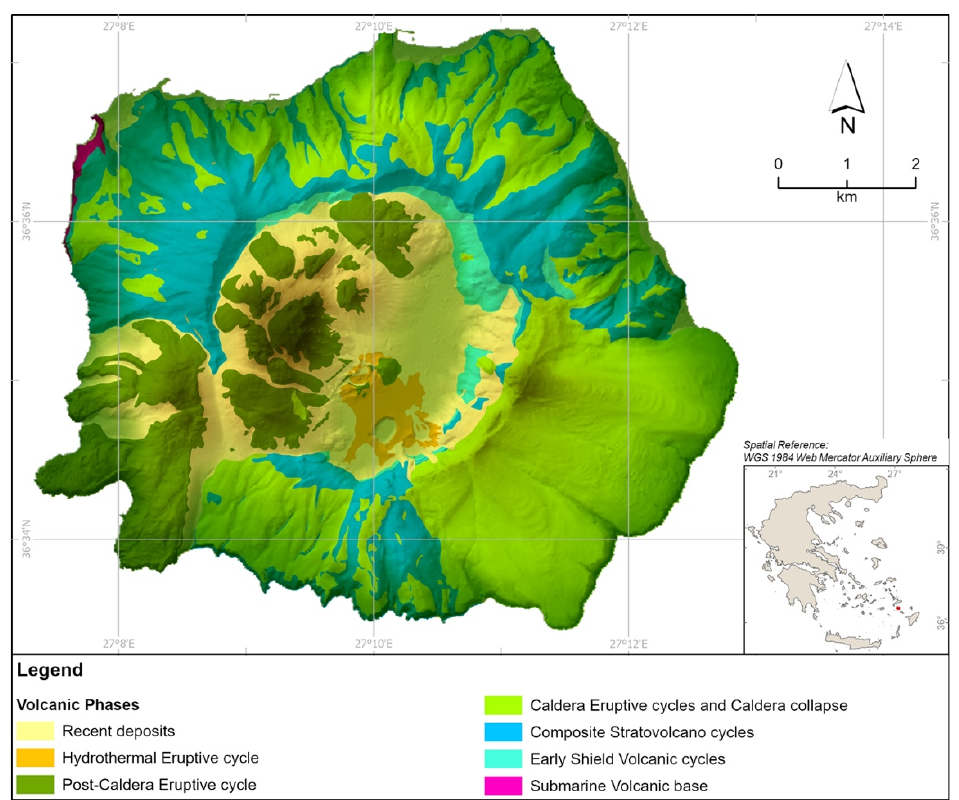
Figure 3. Volcanic phases of Nisyros volcanic island [29].